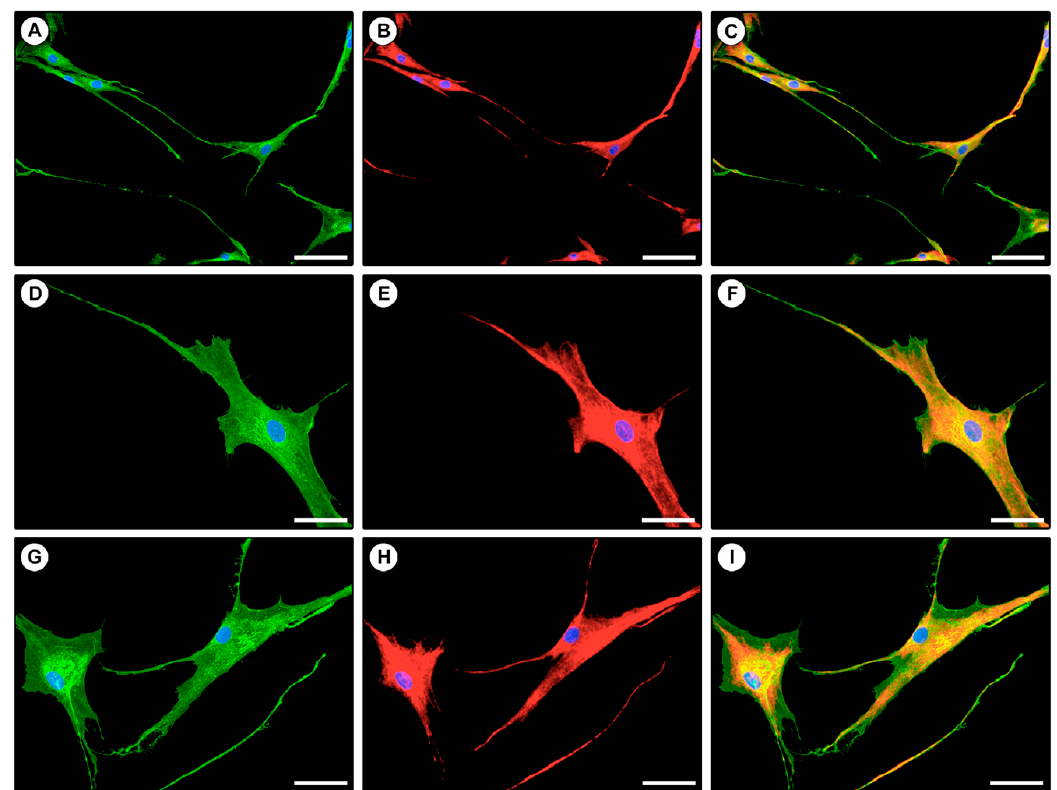
Figure 6. Coexpression of CD34 and PDGFR α in isolated telocytes assessed by double immunofluorescence. ( A – I ) Representative fluorescent microscopic images of purified telocytes double immunostained for CD34 (green) and PDGFR α (red). Single green ( A , D , G ), single red ( B , E , H ) and merged ( C , F , I ) images are shown. Nuclei are counterstained in blue with 4 ′ ,6-diamidino-2-phenylindole (DAPI). Original magnification: ×20 ( A – C ), ×40 ( D – I ). Scale bar: 100 µm ( A – C ), 50 µm ( D – I ).